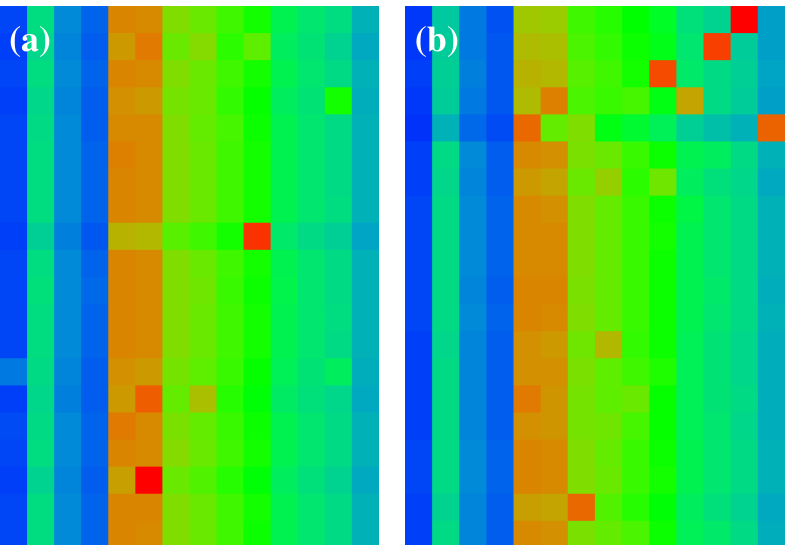
Figure 6. Zoomed parts of sensitivity matrix D ab of Figure 5. Both panels show a selected subregion of Figure 5 with the index a (vertical axis from top to down) belonging to the set of up-nodes ( a = 5, . . . ,24 in panel ( a )) or down-nodes ( a = 25, . . . ,44 in panel ( b )) and the index b (horizontal axis from left to right) corresponds to both panels to the four nodes of the TGF- β subgroup ( b = K t = 1, . . . 4 for four left columns in each panel) and the 10 nodes of the X -proteins ( b = 45, . . . 54 or K x = 1, . . . ,10 for 10 right columns in each